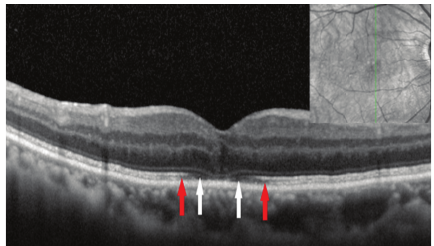
Figure 5: Spectral-domain optical coherence tomographic (SD- OCT) image of an eye 3 weeks after macular hole repair (72-year-old woman). SD-OCT image of a vertical scan was obtained. In addition to photoreceptor inner/outer segment (IS/OS) junction line, the external limiting membrane (ELM) and cone outer segment tips (COST) lines are clearly seen on the SD-OCT image. Red arrows indicate end points of the COST line. White arrows indicate end points of the IS/OS line. The ELM line has been almost restored. Note that the defect length was longest in the COST, followed by the IS/OS and ELM. The direction of photoreceptor restoration is from inside toward